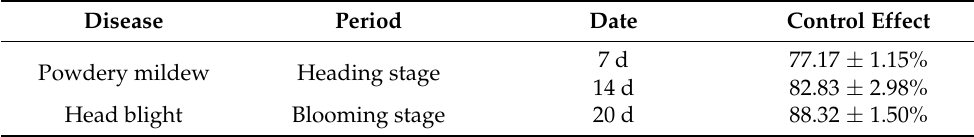
Table 8. Control effects of powdery mildew and head